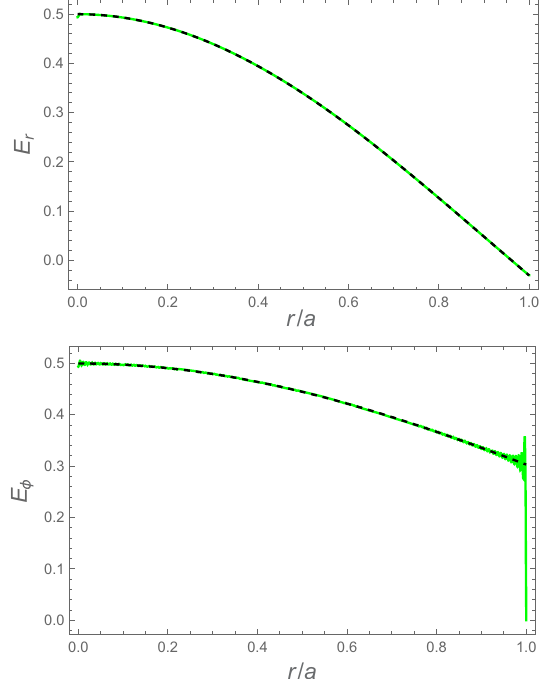
and Eq. (44) for E ϕ , with the r Þ ; B n n